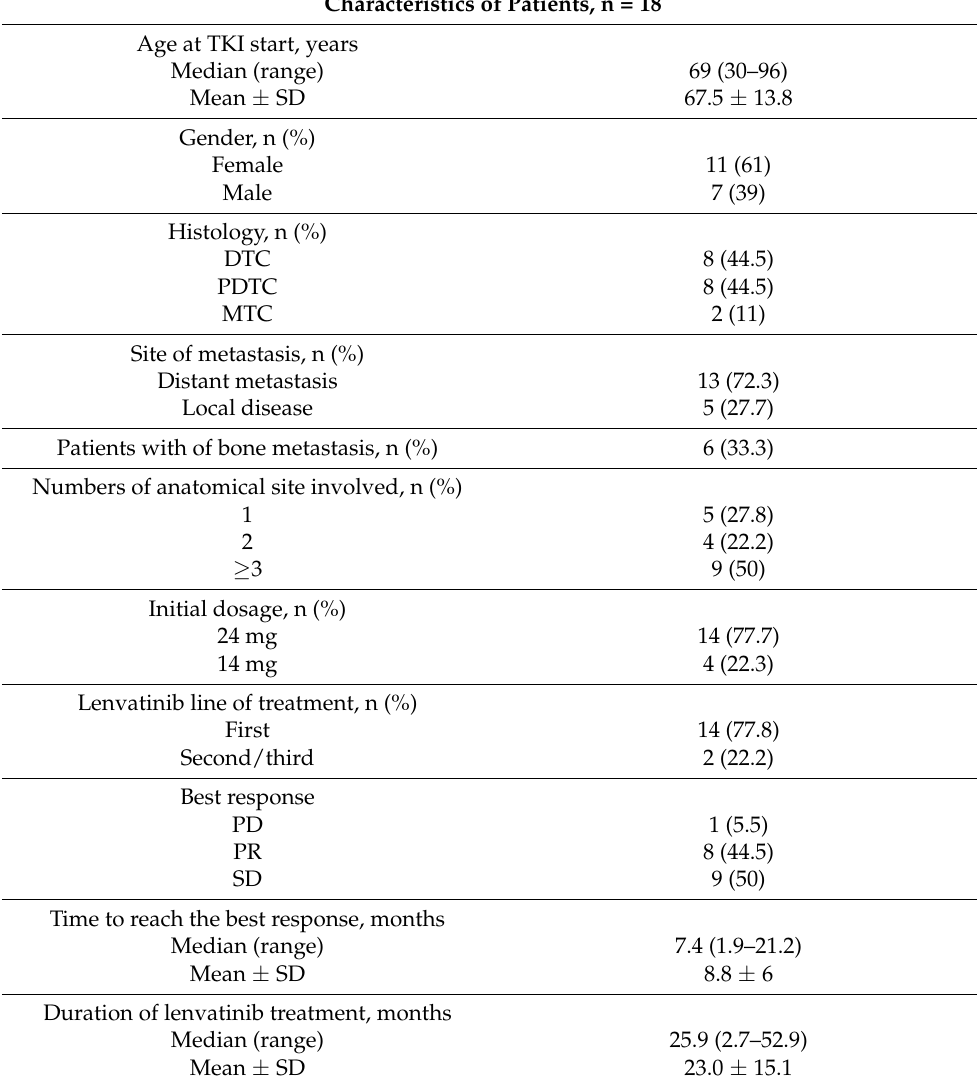
Table 1. Clinical characteristics of